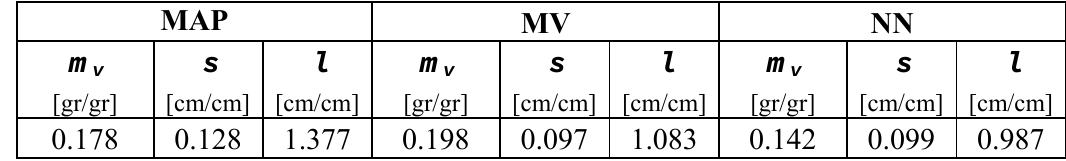
Table 1 . Comparison of retrieval results (in terms of normalized rms error) using MAP, MV and NN algorithms tested on a SEM-derived simulated database. Simulated data